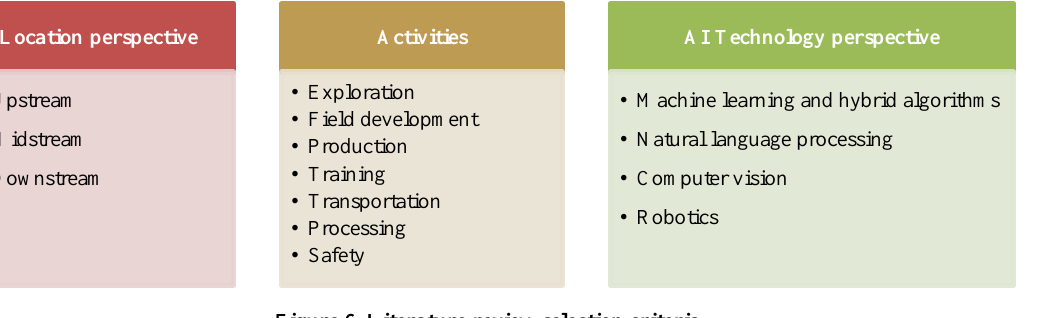
Figure 6. Literature review selection